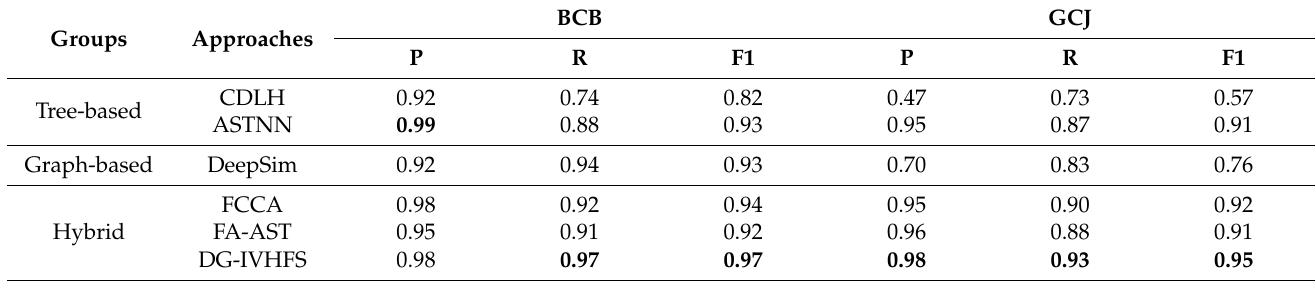
Table 2. Comparison of detection performance on BCB and